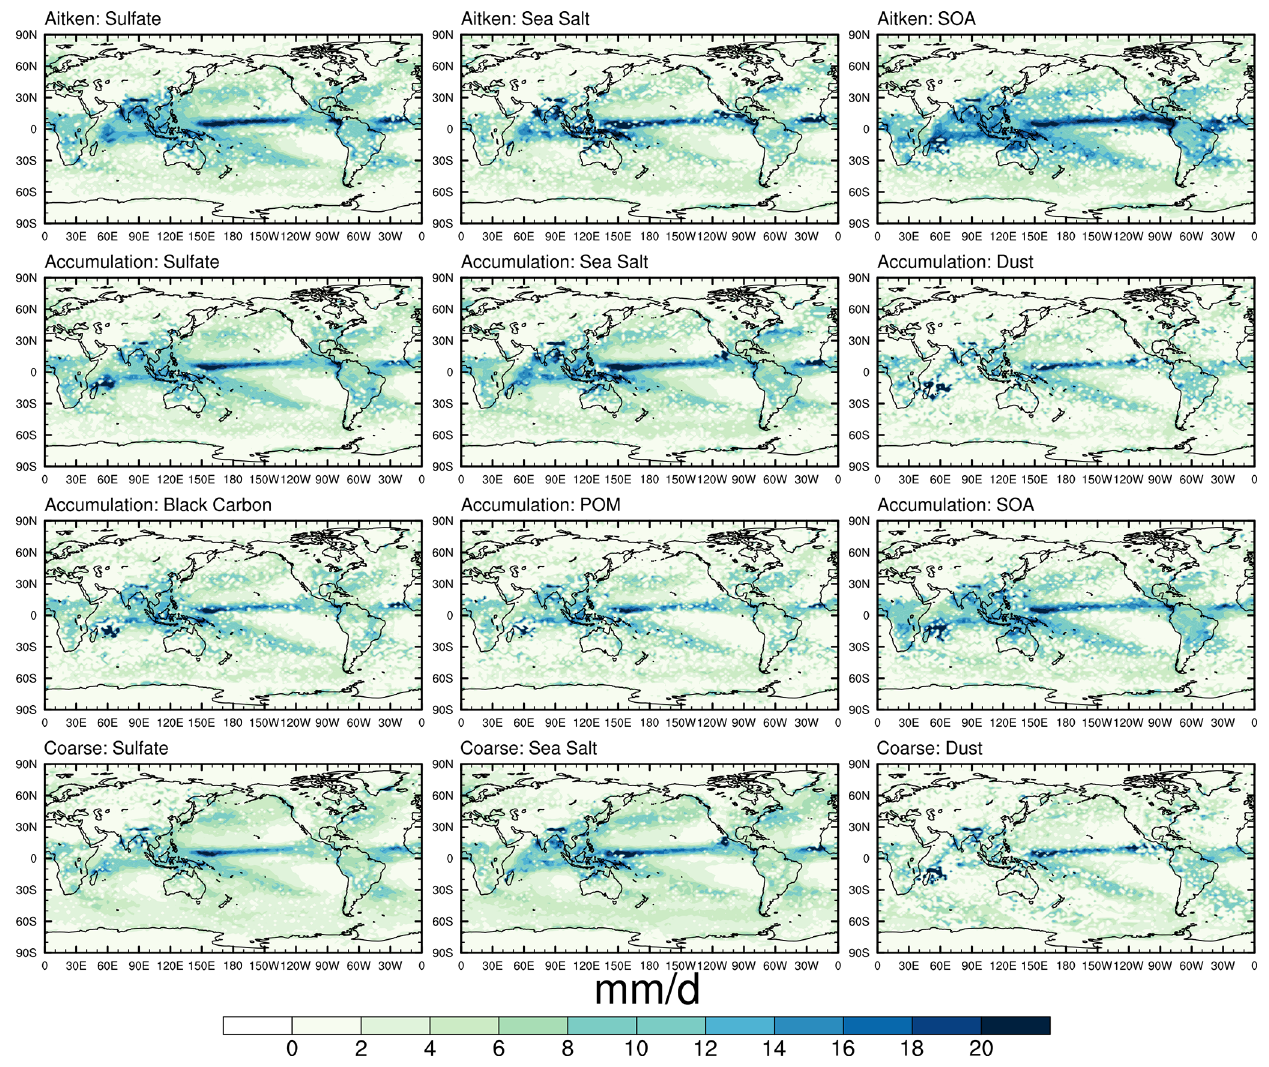
Figure 12. Same as Fig. 11, but for